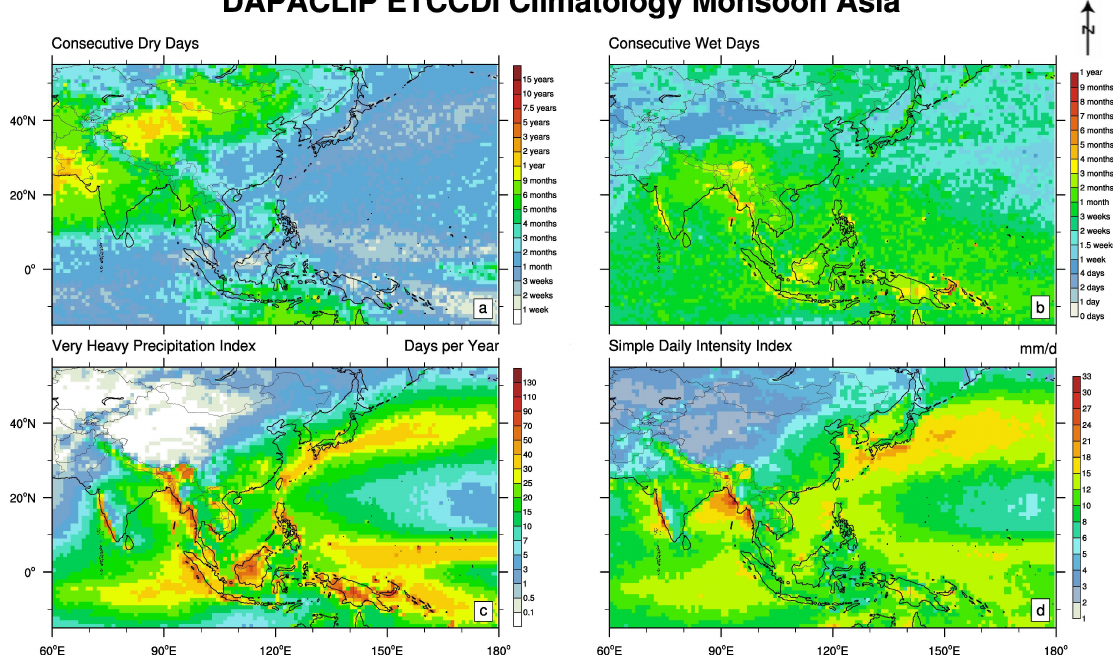
Figure 7. DAPACLIP ETCCDI climatology for the period 1988–2008 for the region of Monsoon Asia in 1.0 ◦ spatial resolution for selected ETCCDI indices. Panel ( a ): cdd index. Panel ( b ): cwd index. Panel ( c ): r20 index. Panel ( d ): sdii